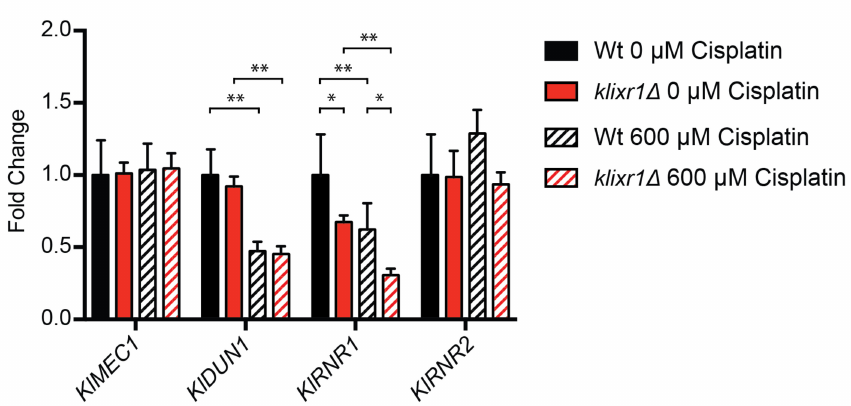
Figure 8. Regulatory role of Kl Ixr1 in the Kl Mec1- Kl Rad53- Kl Dun1–dependent ribonucleotide reduc- tase pathway of K. lactis . mRNA levels of KlMEC1 , KlDUN1 , KlRNR1, and KlRNR2 were analyzed by RT-qPCR in the MW190-9b strain (black) and its derivative ixr1 ∆ (red), before (solid) and after (streaked) the treatment with 600 µ M of the chemotherapeutic agent cisplatin. Housekeeping gene KlTAF10 was used for gene normalization. * p < 0.05; ** p <